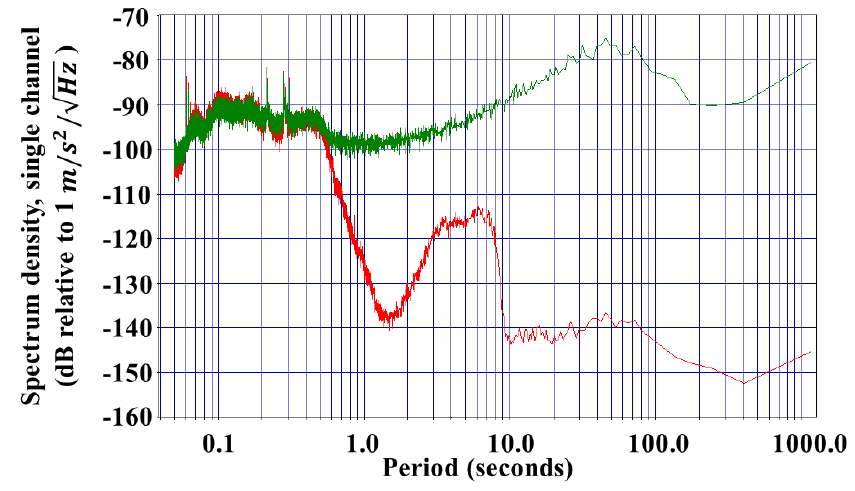
Figure 8. Spectrum density of a fabricated single-50 μm diameter-channel MEMS MET seismometer in comparison with a commercialized seismometer CMG-40T (Guralp Systems Ltd.). Red —CMG-40T, Green —MEMS MET